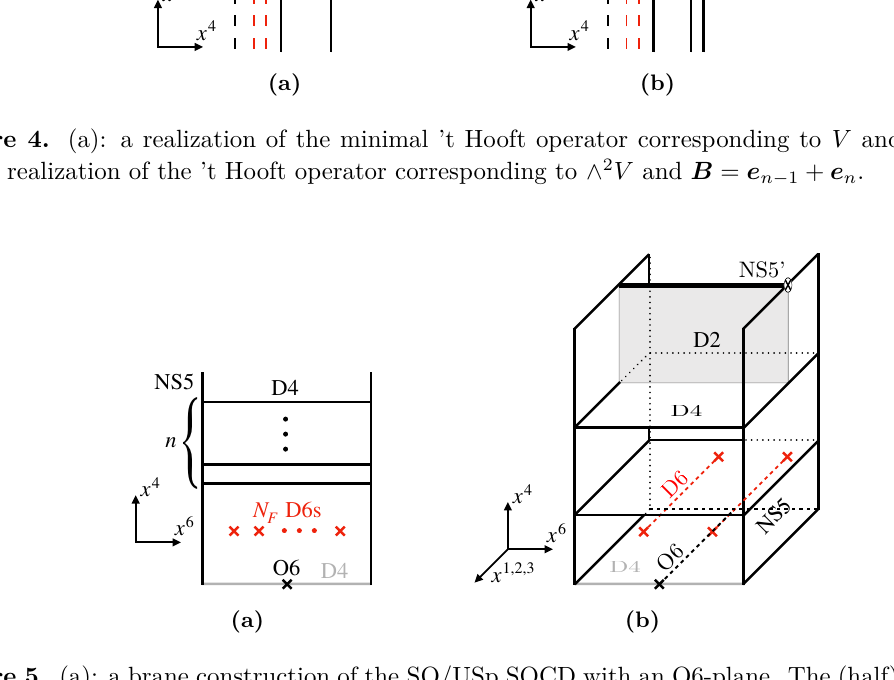
Figure 5. (a): a brane construction of the SO / USp SQCD with an O6-plane. The (half) D4-brane on top of the O6-plane is present only when the gauge group is SO(2 n + 1) . (b): a realization of the ’t Hooft operator corresponding to the fundamental representation V and B = e n